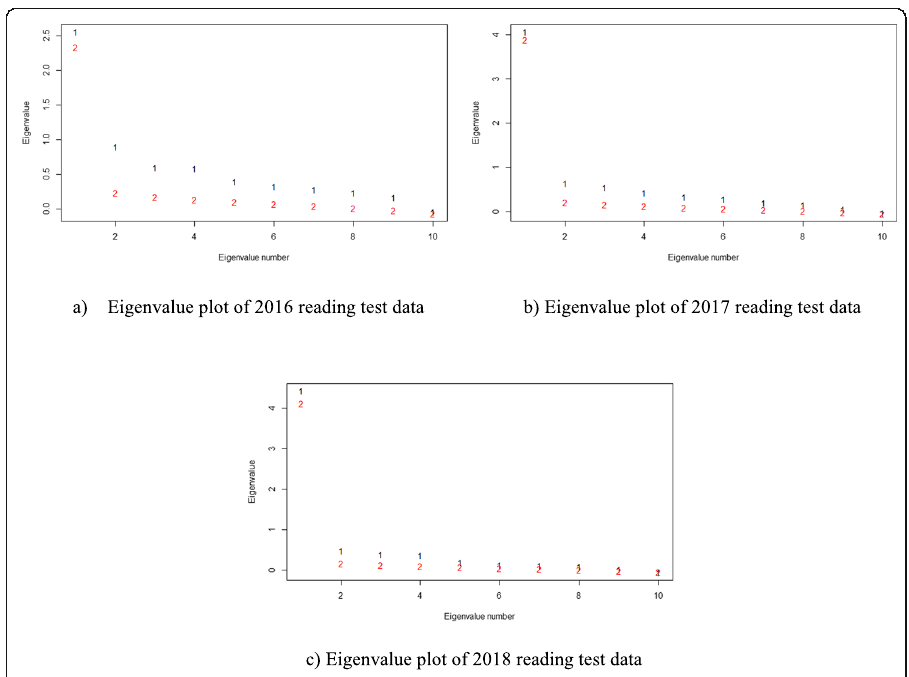
Fig. 3 Eigenvalue plots produced by the unified parallel analysis for the reading comprehension data